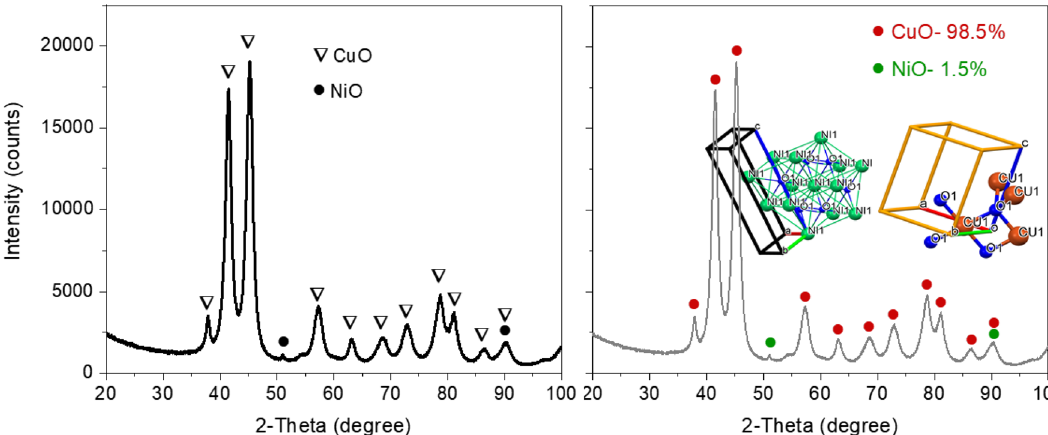
Figure 2. ( a ) XRD pattern of nanoflakes with all peaks explained by CuO as a major phase and NiO as a trace phase. ( b ) Rietveld fit analysis for composition with relative abundances of Tenorite (CuO) and NiO. Inset: The unit cell of